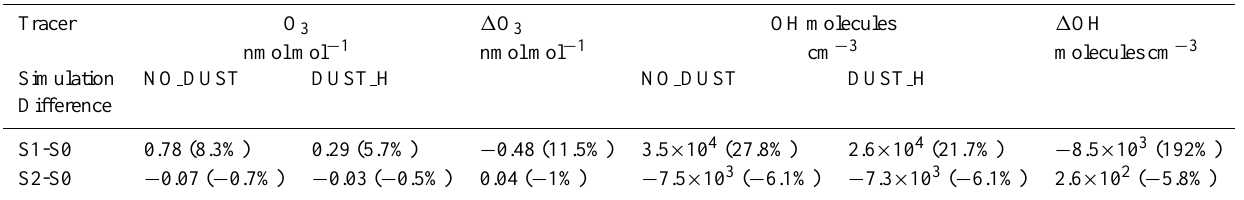
Table 9. Results from the sensitivity simulations with additional surrogate VOC emissions in the NO DUST and DUST H simulations. “S1” and “S2” represent the results of the simulations with 25% of total VOC (as C-atoms) emission distributed to C3H6 and C4H10, respectively. “S0” represents the results in Sect. 3.2. Listed in the table are the differences (calculated as S1-S0 and S2-S0) in O3 mixing ratio and OH concentration for the NO DUST and DUST H simulations, and the uncertainties in the dust heterogeneous influences. “ 1 ” means the dust heterogeneous influences calculated as DUST H − NO DUST; The relative differences (calculated as (S1-S0)/S0 and (S2-S0)/S0) are shown in